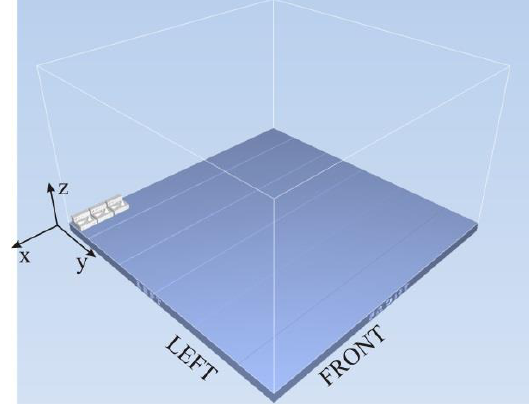
Figure 3. Test plate dimensions.